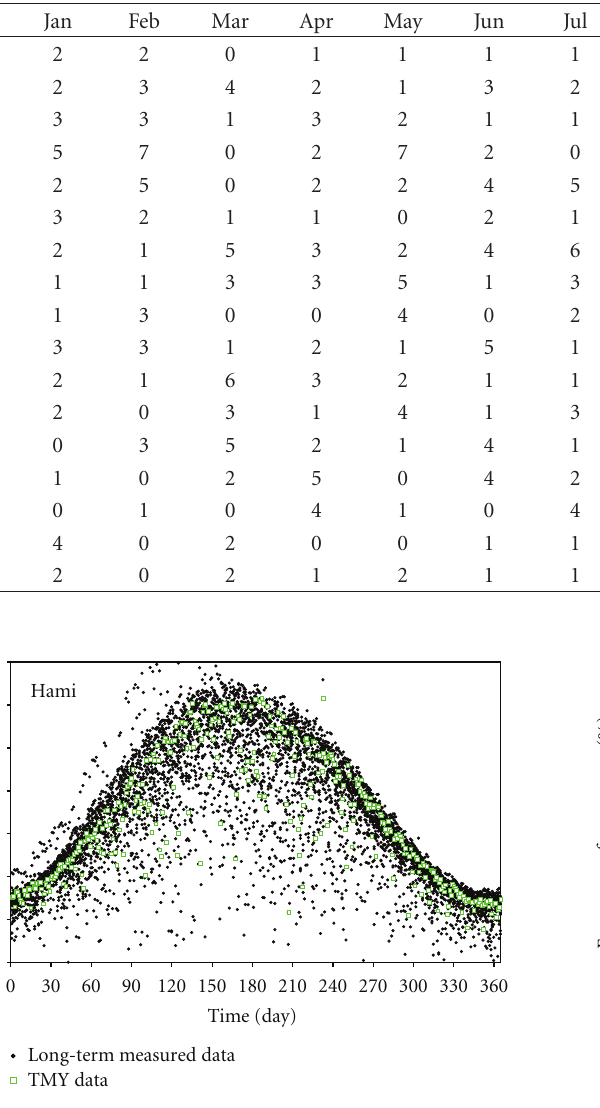
Figure 4: Variation of typical solar radiation data and long-term (1994–2010) measured data for Hami station.